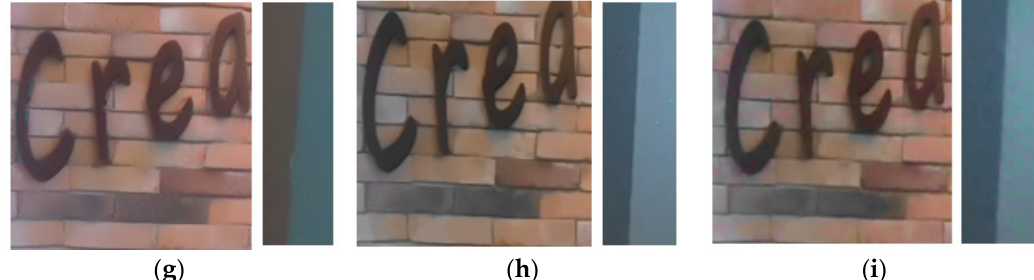
Figure 6. Subjective quality of Piano . ( a ) Full image of original; ( b ) original; ( c ) BM3D; ( d ) VBM4D; ( e ) MSEPLL; ( f ) 3D focus; ( g ) MVCNN; ( h ) LFBM5D; ( i ) proposed.